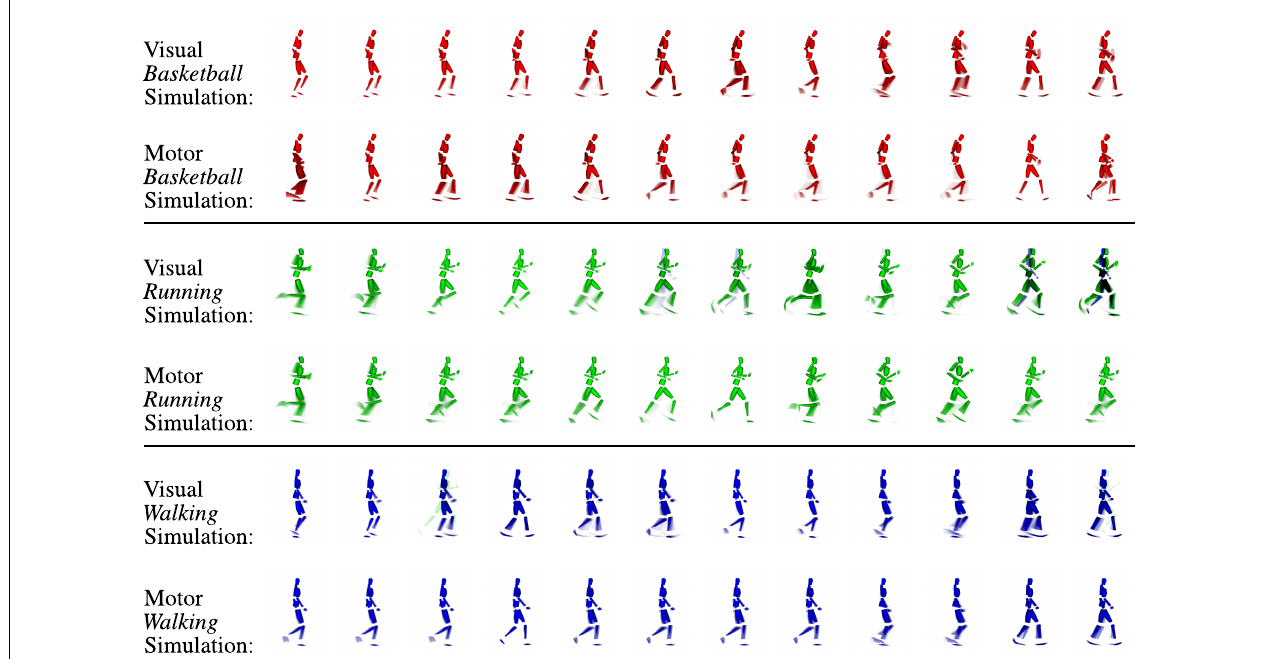
FIGURE 11 | Example clips of the state sequences simulated synchronously in the visual and motor modalities when three different intention priors ( basketball , running , and walking ) are provided . Each row shows the respective modality and intention prior. As during motor inference, snapshots at the same position mostly show very similar parts of the movements, while misalignments are mostly avoided. Again, the network maintains the activation cycle of the movement-specific states because pattern transition probabilities are biased by the provided top-down-propagated intention